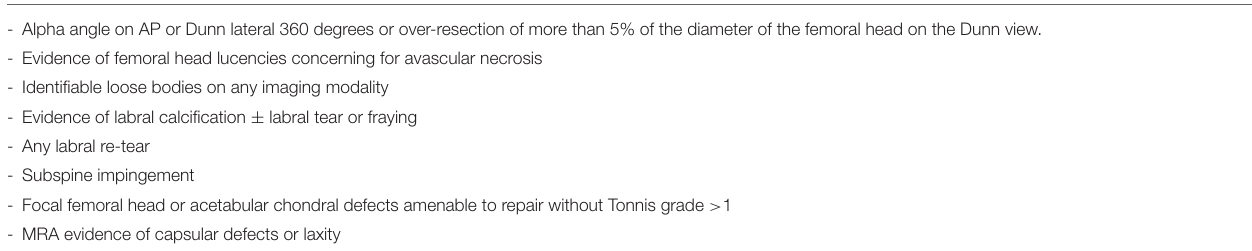
TABLE 1 | Indications for revision hip